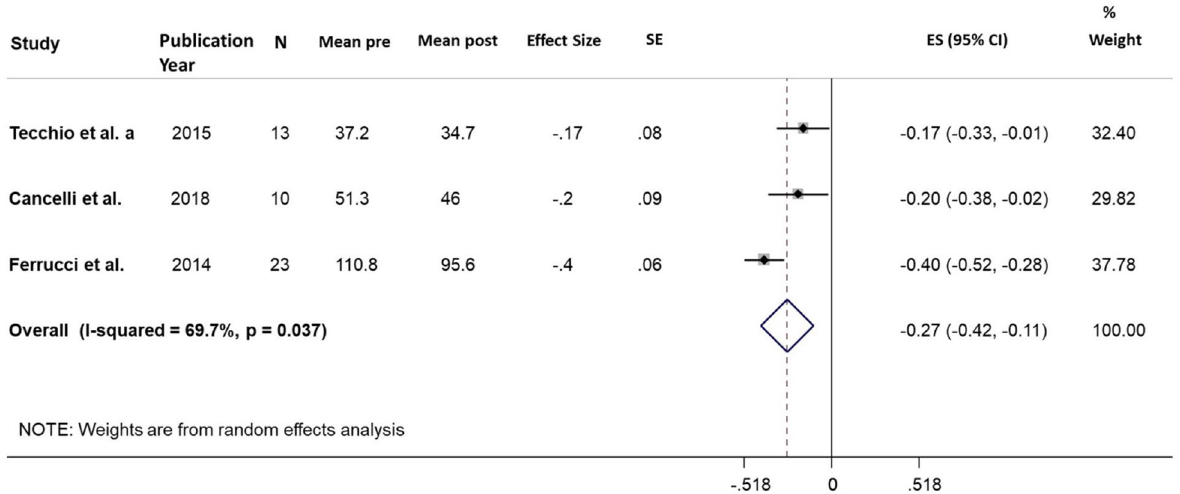
Figure 7. MS Fatigue. Sham. Forest plot of meta-analysis results considering all studies. The diamond represents the pooled standardized mean difference (SMD, dashed red vertical line) and its 95% confidence interval; vertical solid dark line is the line of equivalence. The estimates for each study and their 95% confidence intervals are represented by a box with whiskers, the dimension of grey box is proportional to the precision of the study. Note: SE = Standard Error; ES = Effect Size. CI = Confidence Interval.